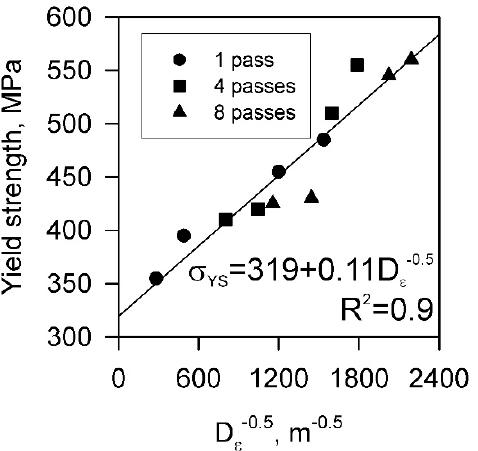
Figure 8. Relationship between the yield strength ( σ YS ) and the grain size ( D ε ) in a Cu-Cr-Zr alloy subjected to ECAE-Conform (1 to 8 passes) followed by cold rolling (up to total strain of 4). Note that the grain size was calculated by Equation (2).